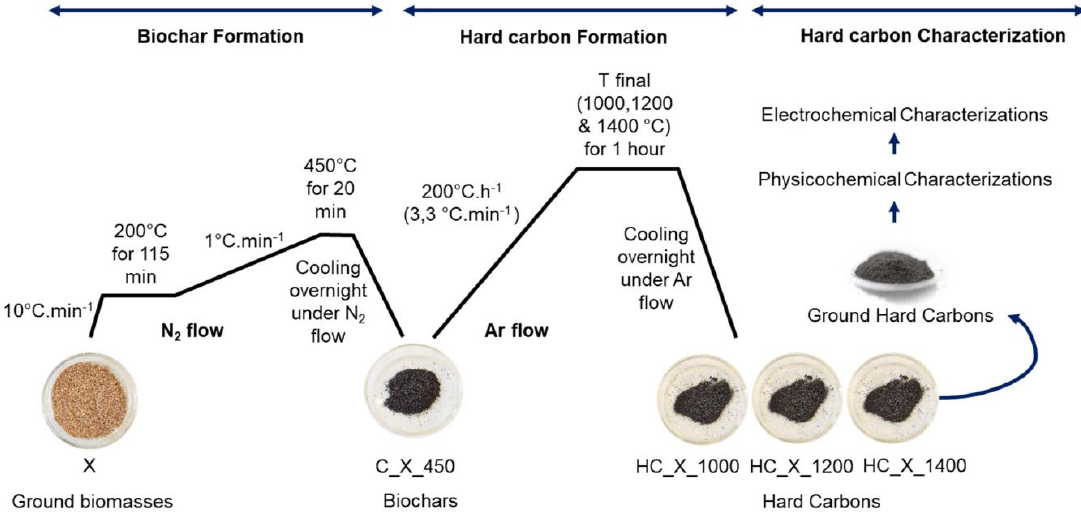
Figure 1. Hard carbon synthesis procedure.